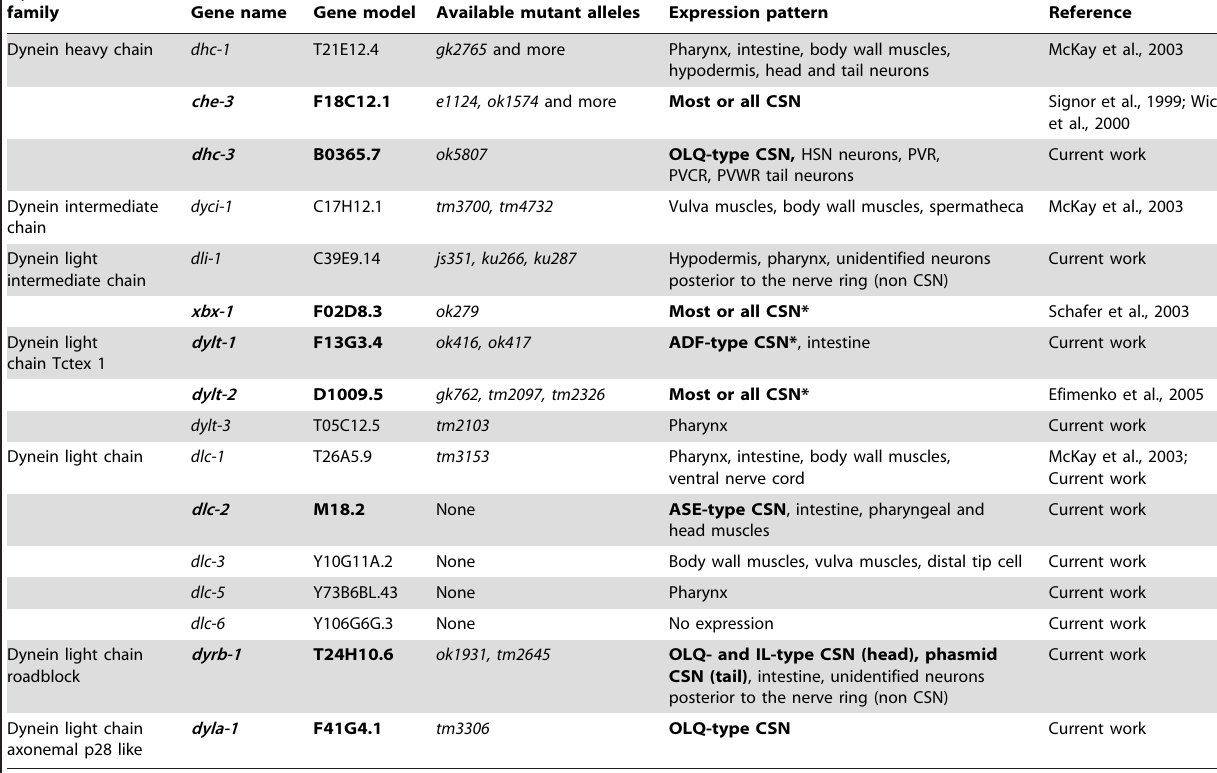
Table 1. Post-embryonic expression patterns of C. elegans dynein